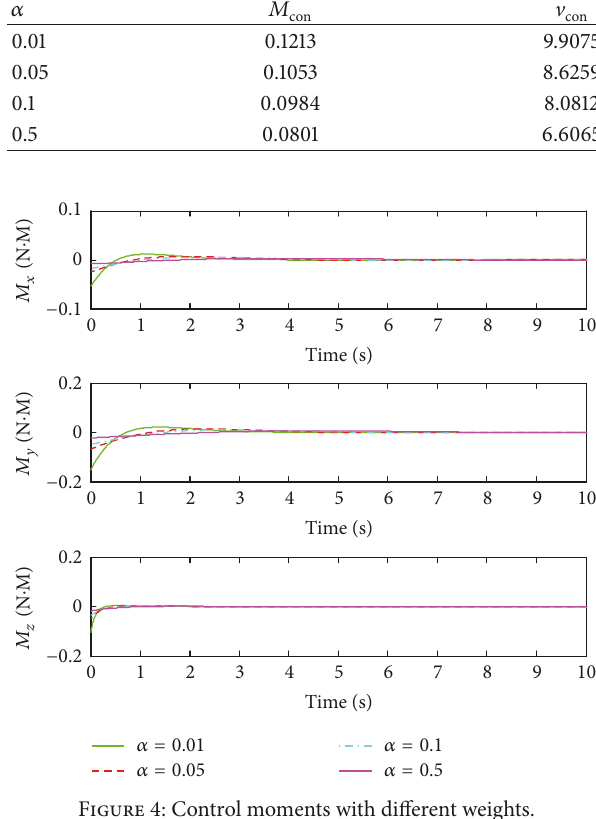
Figure 4: Control moments with different weights.